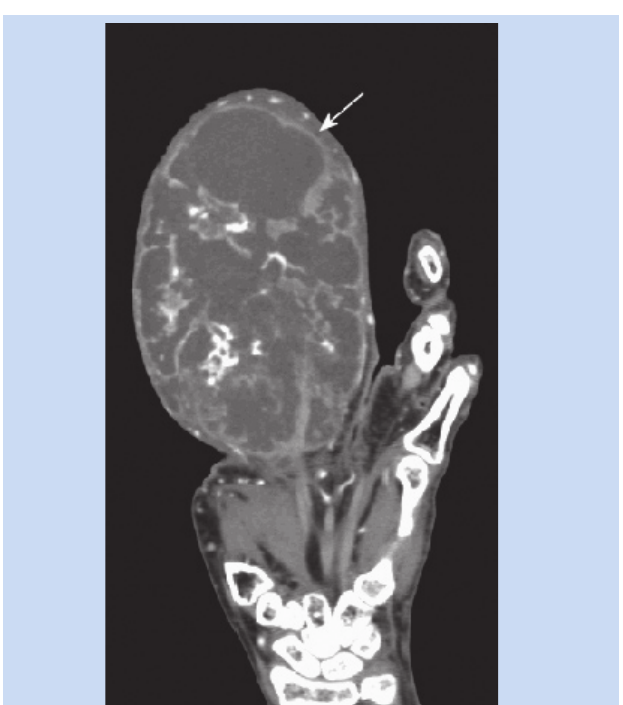
Fig. 2b. Post intravenous contrast-enhanced CT in the coronal view with inhomogeneous mild peripheral rim and septal enhancement of the mass (white arrow).